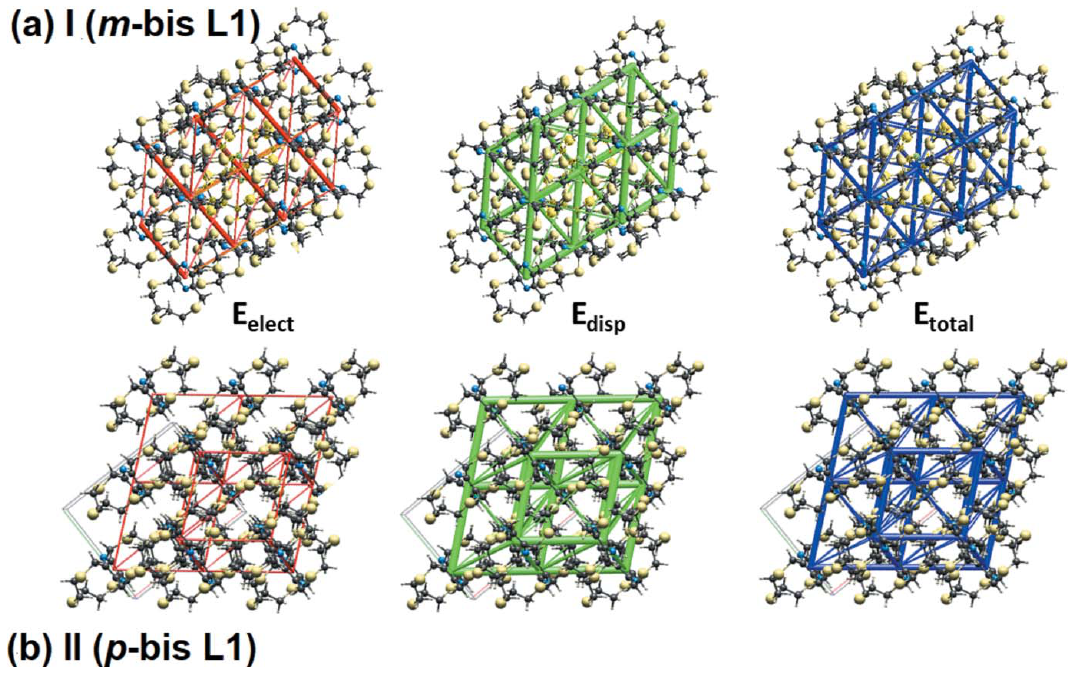
Figure 8 ( a ) The energy frameworks for I viewed down the b -axis direction, ( b ) the energy frameworks for II viewed down the c -axis direction: comprising, E elect (electrostatic potential forces), E disp (dispersion forces) and E total (total energy) for a cluster about a reference